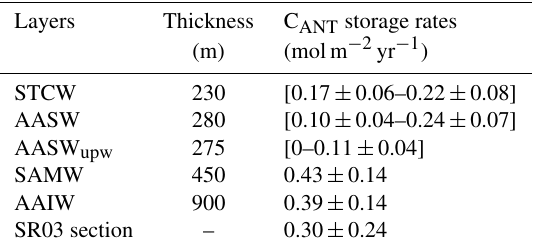
Table 6. Approximated rates of C ANT storage based on the trends from Table 4.